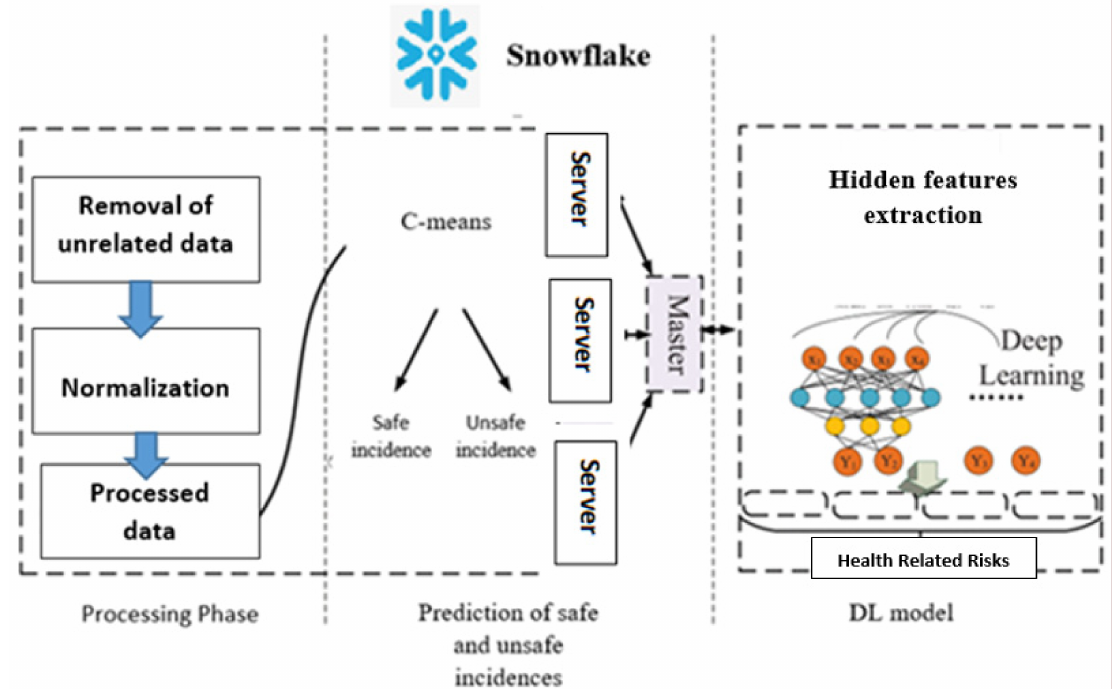
Figure 2. The three phases of the monitoring and prediction framework. The first phase of the monitoring prediction comprises the analysis of the class attributes with data processing and the removal of unrelated data. Furthermore, normalization is performed to obtain the processed data. The second phase predicts safe and unsafe incidences based on the scalable clustering algorithm. In the final phase, the hidden features are extracted using DL